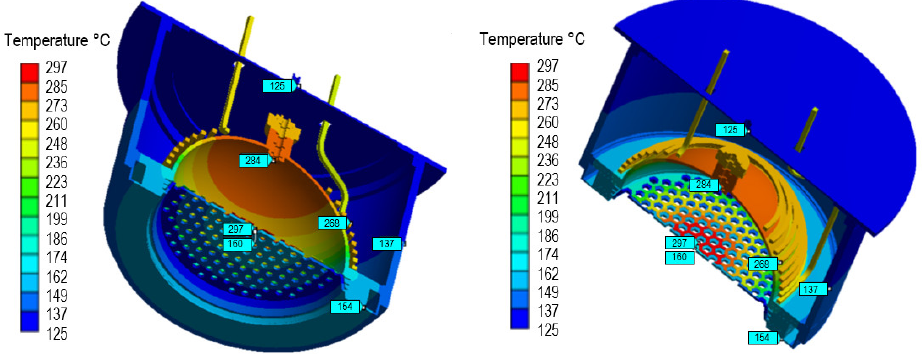
Figure 18. Electrode deflection w(0) as a function of temperature differential along the electrode radius calculated by simplified algorithm and in the ANSYS software.